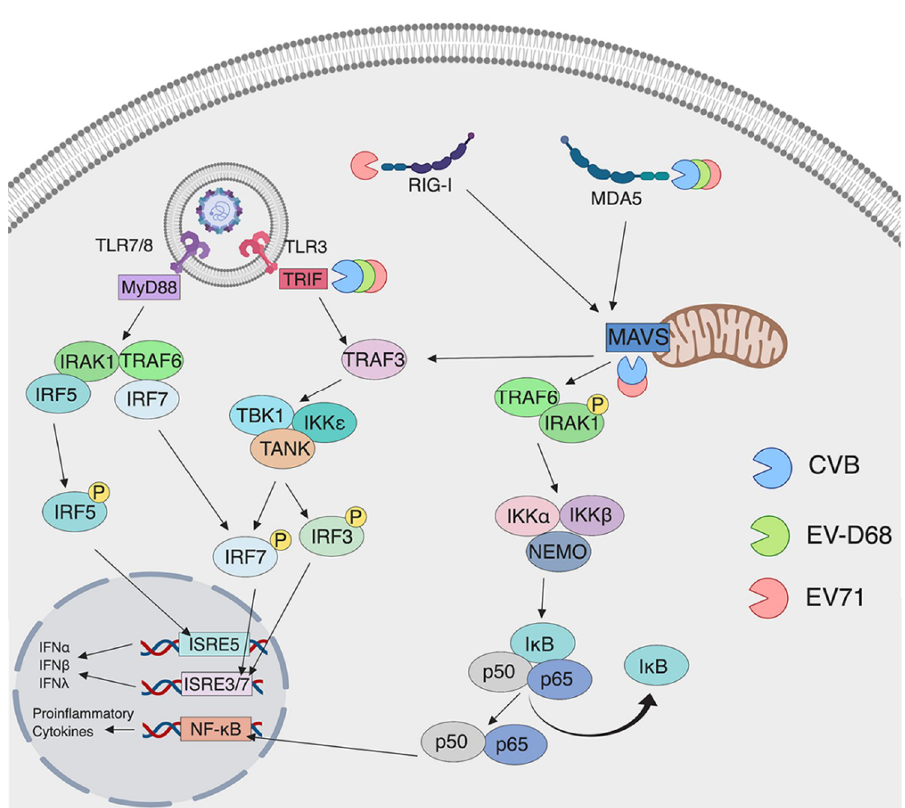
Figure 3. Enterovirus evasion strategies of PRR-mediated signaling. Enteroviruses target innate immune signaling proteins through cleavage by the viral proteases 2A and 3C. Shown are the targets for the CVB (blue), EV-D68 (green) and EV71 (red) proteases. All three viral proteases target MDA5 and the TLR adaptor protein, TRIF, as mechanisms to halt antiviral innate immune signaling in infected cells.